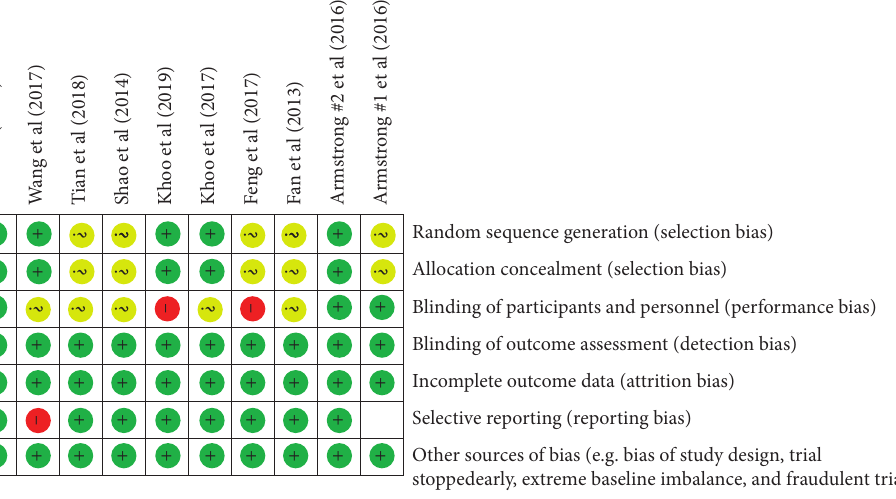
Figure 2: Details of quality assessment of the included